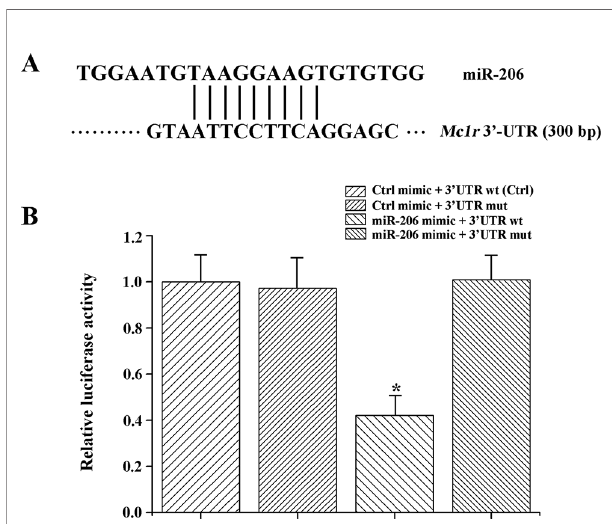
FIGURE 2 | MiR-206 acts directly at the 3'-UTR of Mc1r . (A) The alignment between the miR-206 and 3'-UTR segment of Mc1r . (B) Dual luciferase reporter assay system was used to test binding between miR-206 and Mc1r in HEK293T cells. The treatment of control mimic + 3'-UTR wt in HEK293T cell lines was taken as the control group. * P < 0.05.